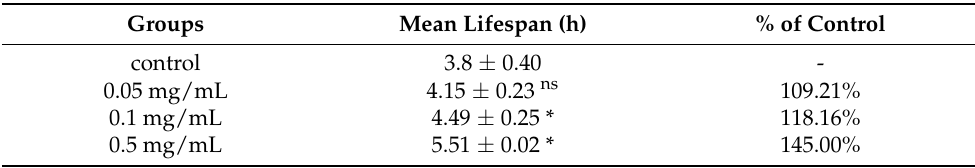
Table 4. Impact of SPO on the antioxidative damage in C. elegans .